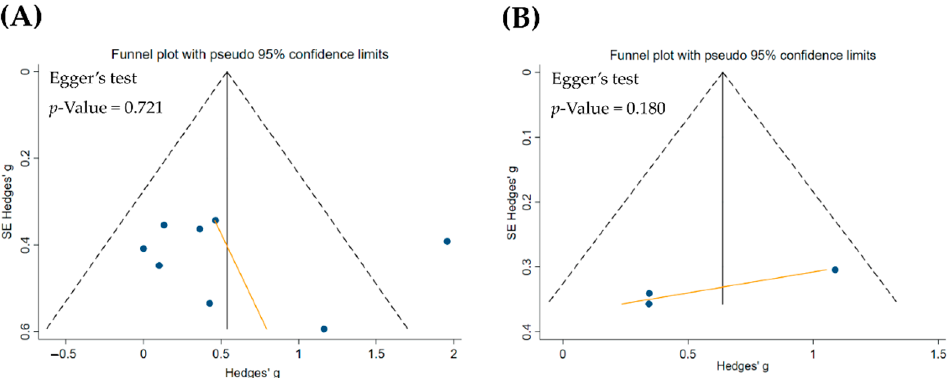
Figure 2. Funnel plot and Egger test assessing publication bias for theta activity neurofeedback training (NFT) on working memory (WM) ( A ) and episodic memory (EM) ( B ). Each point represents an independent study for the indicated associate.